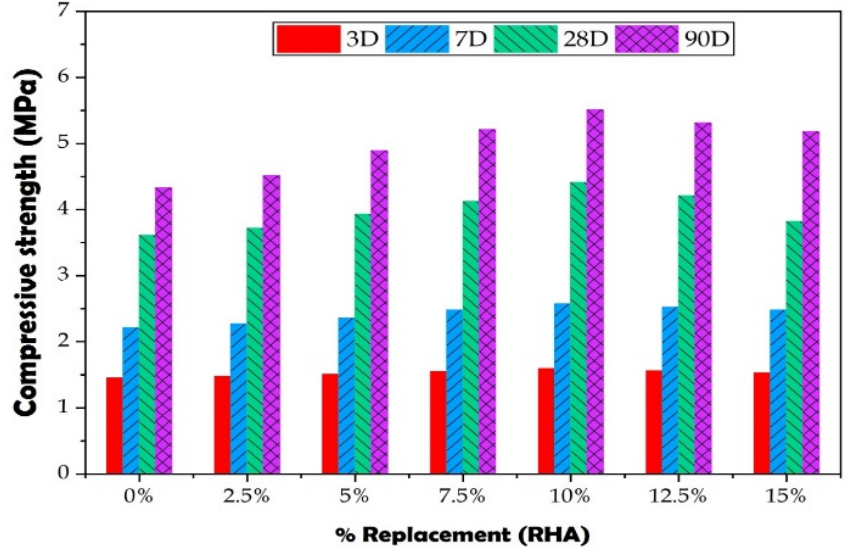
Figure 7. Compressive strength of aerated concrete (D—days).